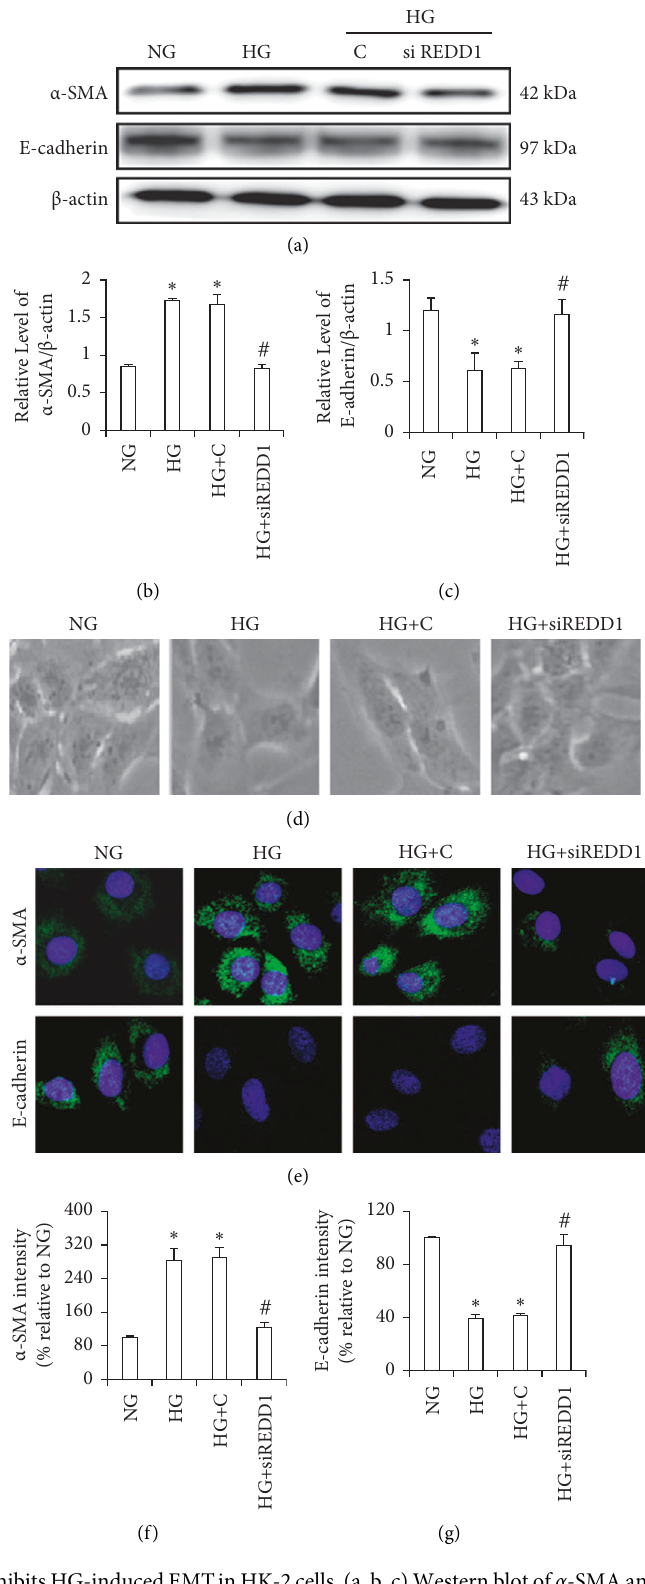
Figure 6: Knockdown of REDD1 inhibits HG-induced EMTin HK-2 cells. (a, b, c) Western blot of α -SMA and E-cadherin in HK-2 cells. (d) The inverted microscope was used to observe the morphological changes of HK-2 cells cultivated under various circumstances. (e, f, g) Immunofluorescence was used to detect the expression of α -SMA and E-cadherin in HK-2 cells. Values are expressed as means per group). NG: 5.6 mM D-glucose; HG: 30mM D-glucose; HG +C: 30mM D-glucose plus scramble. HG+siREDD1: 30mM D-glucose plus REDD1